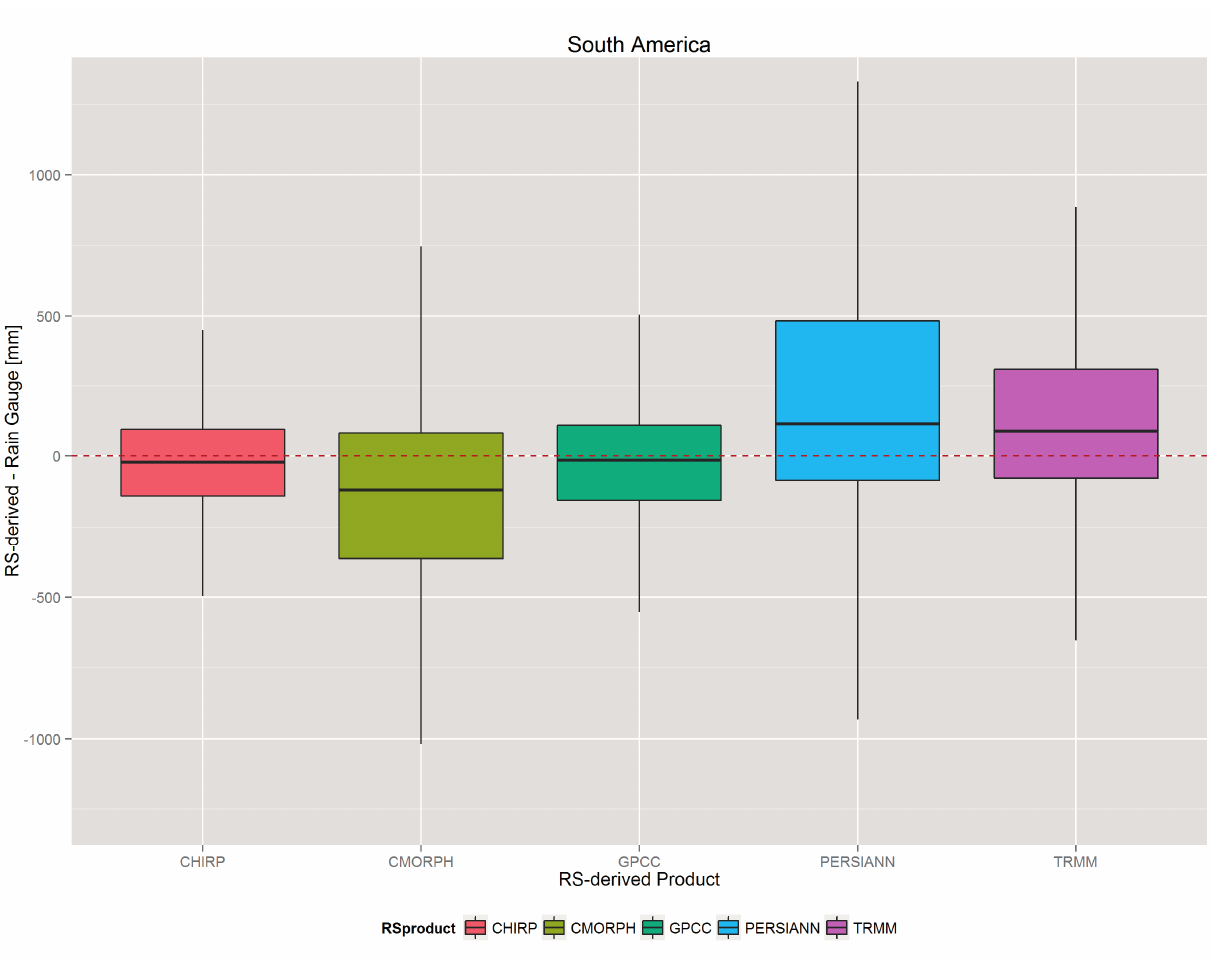
Figure 8. Box-and-Whiskerplot of the difference between downscaled and observed precipitation across the entire South America for different RS